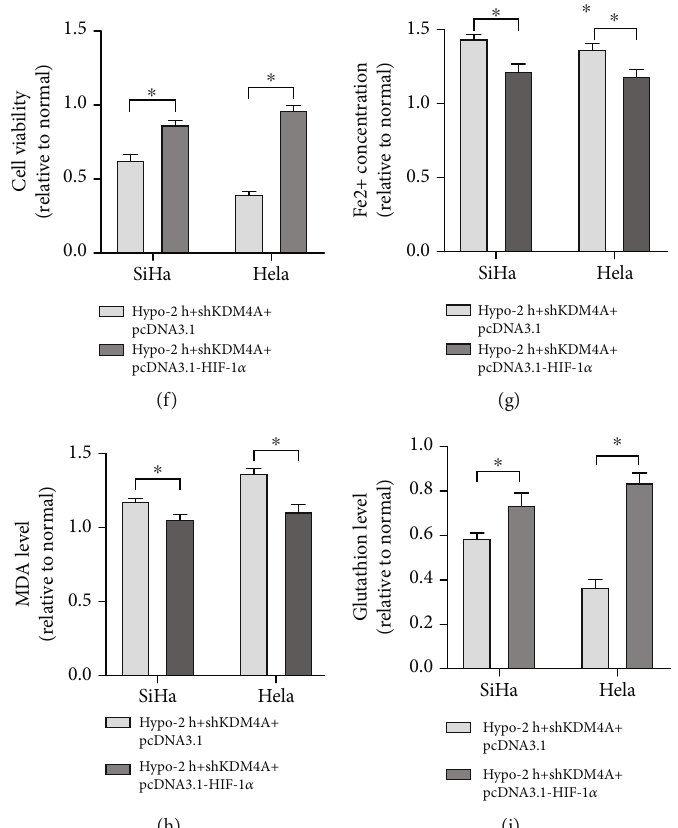
Figure 5: Hypoxia upregulated KDM4A/HIF1 α resistance to ferroptosis in CC cells. SiHa and Hela cell lines were simultaneously transfected with shKDM4A and pcDNA3.1-HIF1 α , followed by hypoxia treatment. (A-B) The mRNA and protein levels of HIF1 α were detected by RT-qPCR and Western blot; (C) The level of H3K9me3 in HIF1A promoter was detected by ChIP assay; (D-E) The transfection e ffi ciency of pcDNA3.1-HIF1 α was detected by RT-qPCR and Western blot; (F) Cell viability was determined by MTT assay; (G-I) The intracellular iron concentration, MDA and GSH levels were measured using colorimetry method. The experiments were conducted in 3 replicates independently. The data were expressed as mean ± standard deviation. The independent t test was employed for comparisons between two groups. ∗ p < 0 : 05